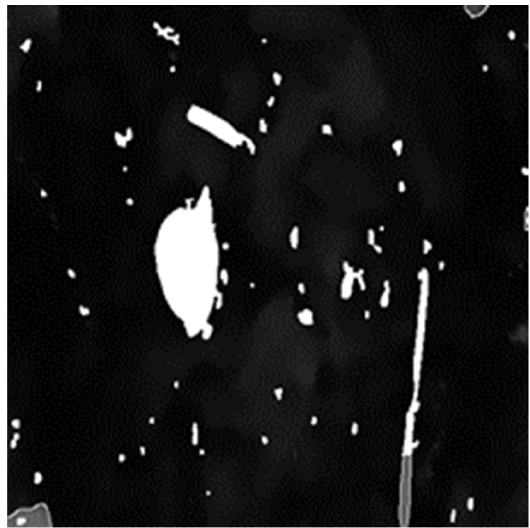
Figure 12. Image-addition operation.